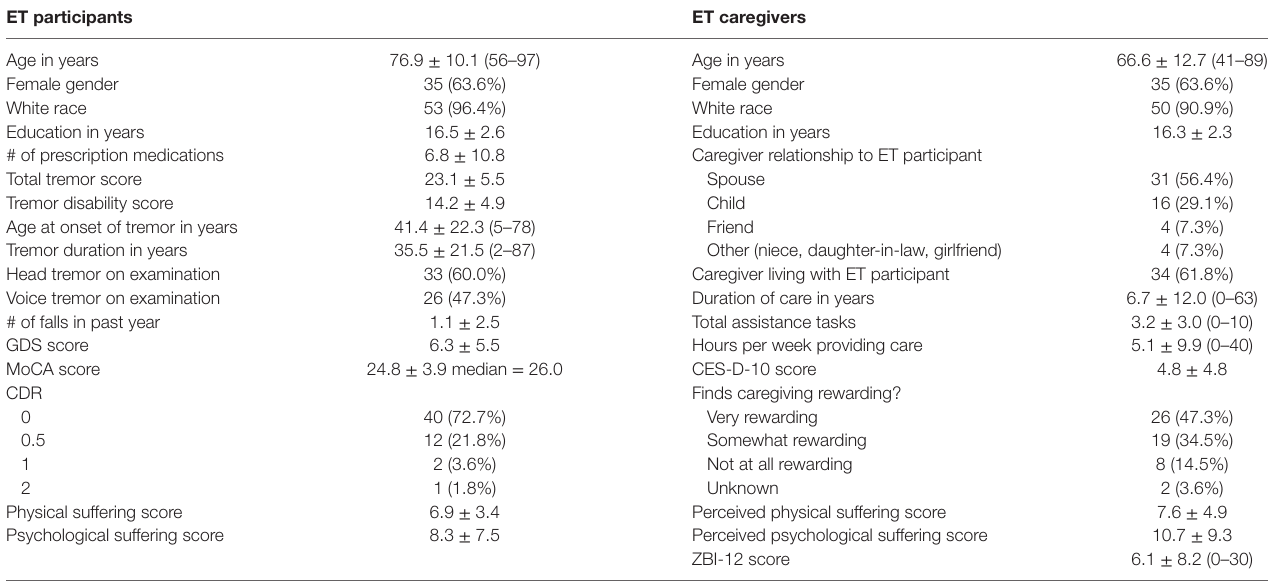
TaBle 1 | Descriptive variables for ET participants ( n = 55) and caregivers ( n = 55). eT participants eT